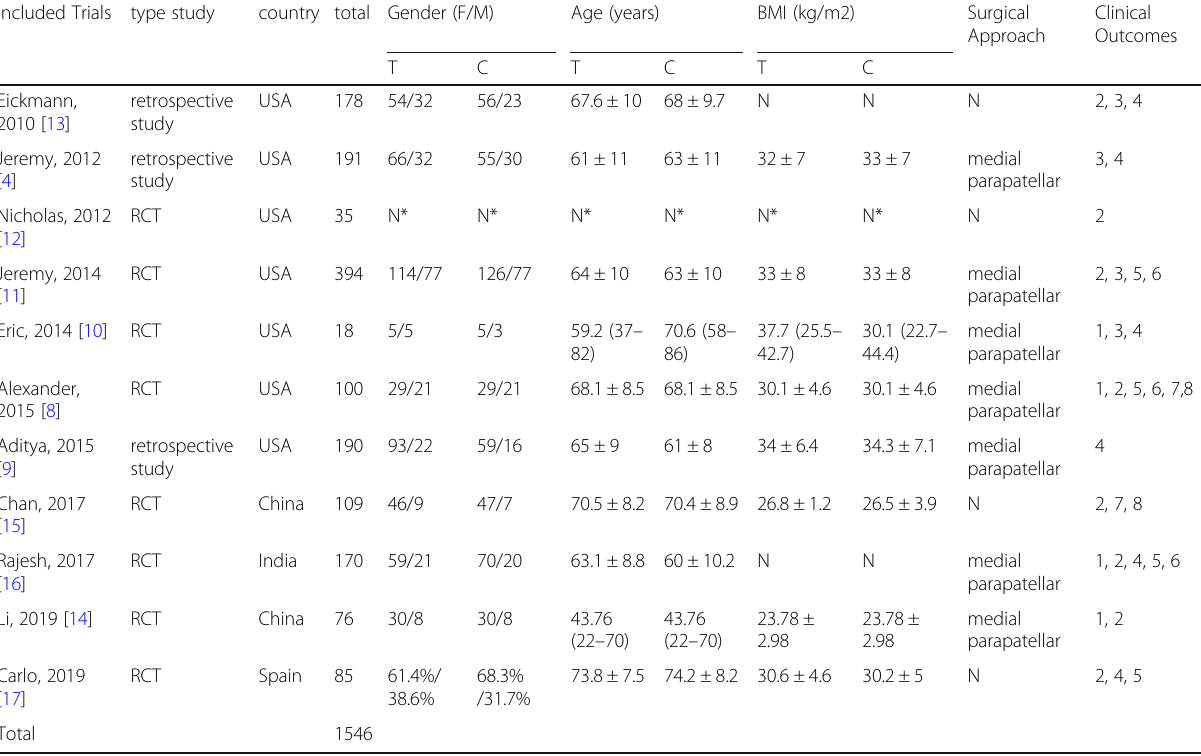
Table 1 Demographic Characteristics and Surgical Approach Included Trials type study